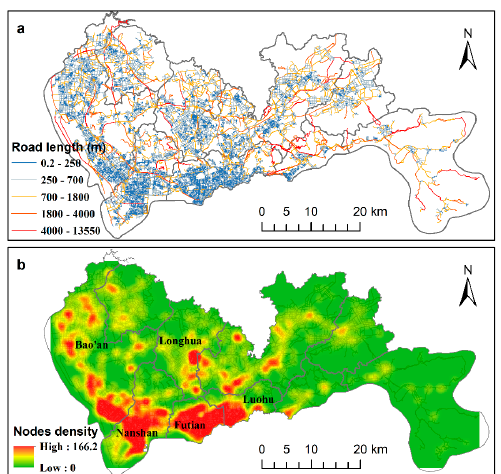
Figure 2. Spatial distribution of the road net and road lengths in Shenzhen City ( a ) and density of nodes in Shenzhen City ( b ). The nodes density used the kernel density estimation (KDE) in a default searching radius.